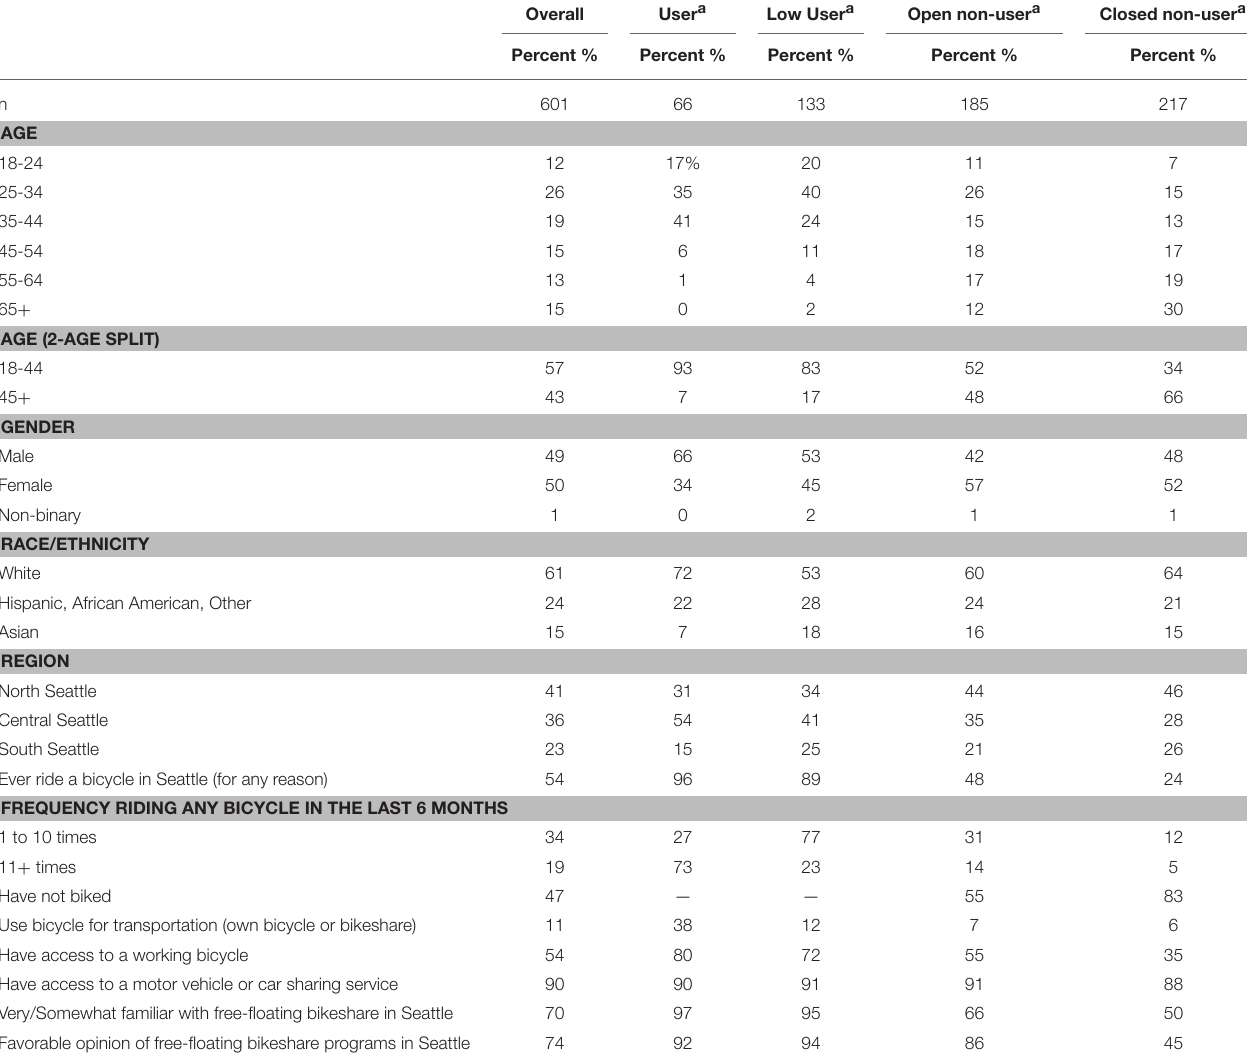
TABLE 1 | Characteristics of all adult Seattle survey respondents overall ( n = 601) and by reported level of free-floating bikeshare use (February